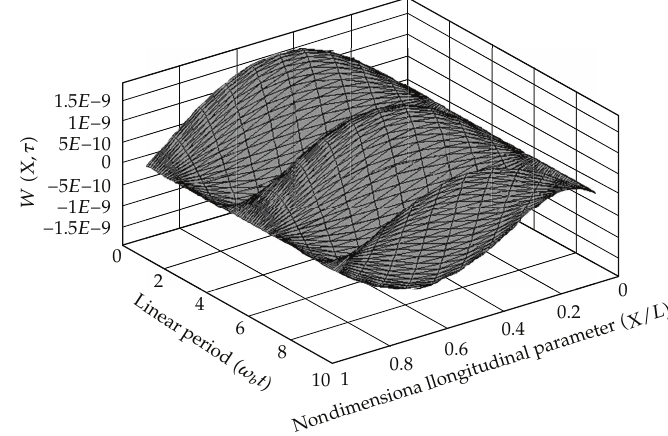
Figure 8: Amplitude-time-space diagram of an S-S SWNT (cid:3) k (cid:8) 10 7 N/m 2 and X (cid:8) 2 (cid:4) .